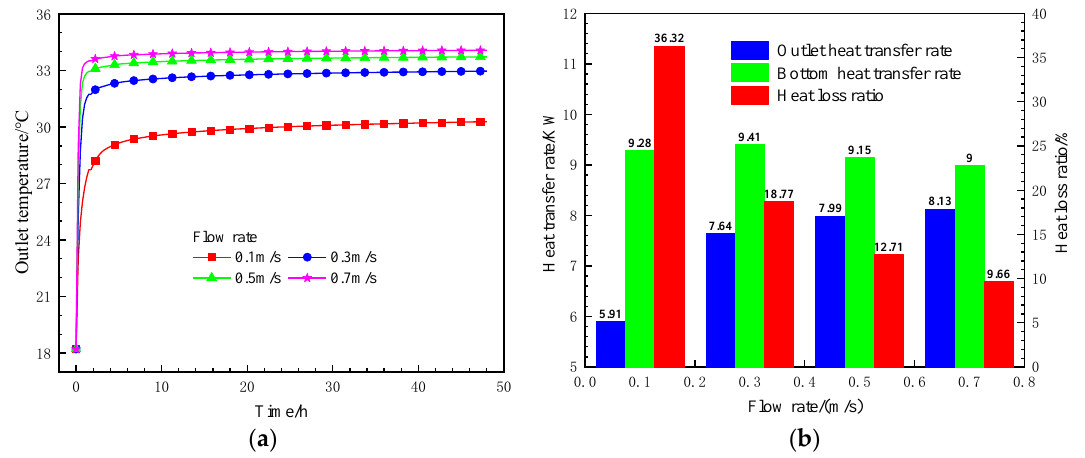
Figure 15. Sensitivity of outlet temperature and heat transfer rate to flow rate. ( a ) Sensitivity of outlet temperature to flow rate. ( b ) Sensitivity of heat transfer rate and heat loss ratio to flow rate.